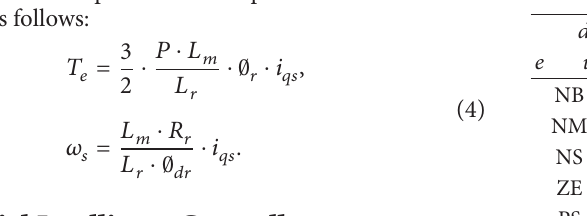
Table 1: Inference